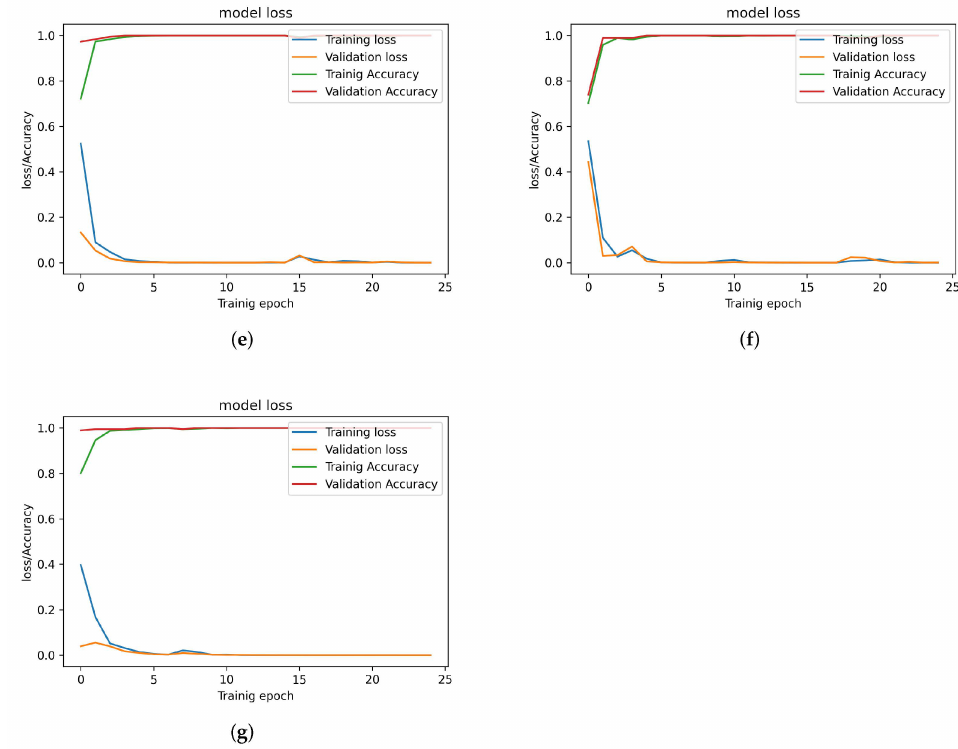
Figure 12. Training and validation loss and accuracy for different trained models (Using 2 Sensors’ readings. ( a ) LSTM model. ( b ) 2 Stacked-LSTM model. ( c ) CNN model. ( d ) 2 Stacked-CNN model. ( e ) CNN-LSTM model. ( f ) CNN-(2-LSTM) model. ( g ) (2-CNN)-LSTM